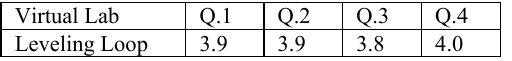
Table 1. Average scores of student responses based on a sample of seven students. Scores range from 1 to